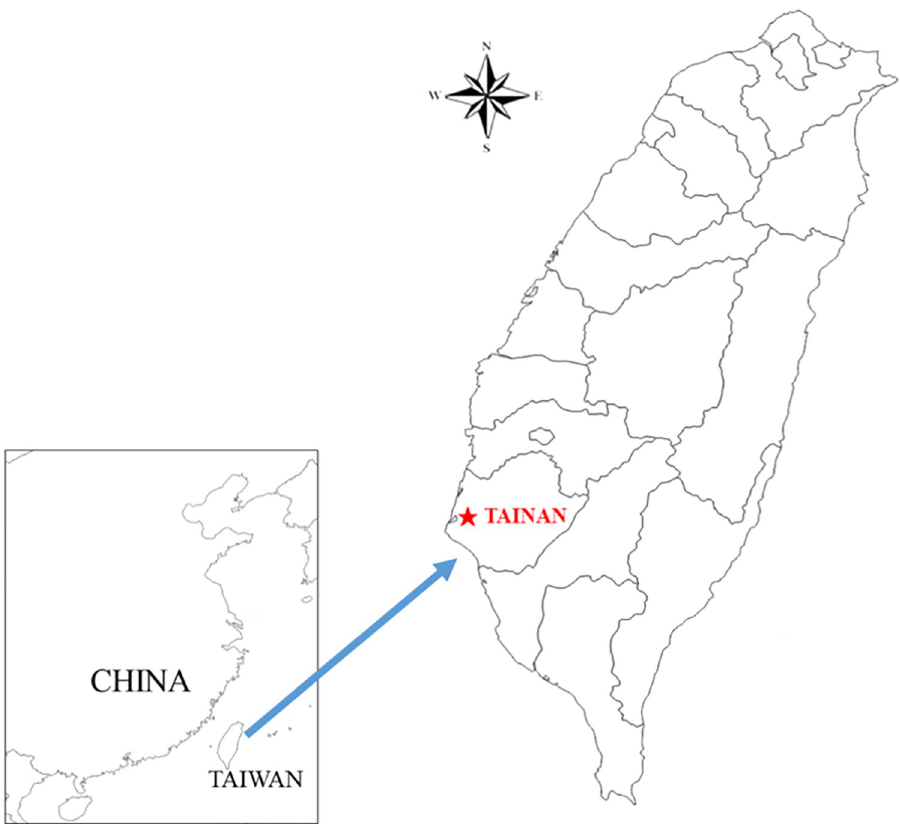
Fig 1. Map of Taiwan showing the collection site ( $ ) for ticks from Tainan City. This map is adapted from free maps (East China map: https://d-maps.com/carte.php?num_car=175&lang=en and Taiwan map; https://d-maps.com/